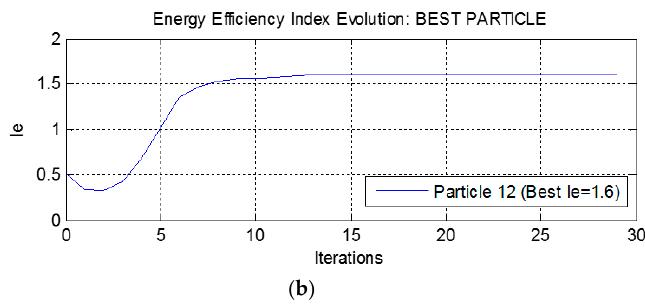
Figure 5. Energy efficiency for swarm with 80 particles: ( a ) all particles and ( b ) best particle.